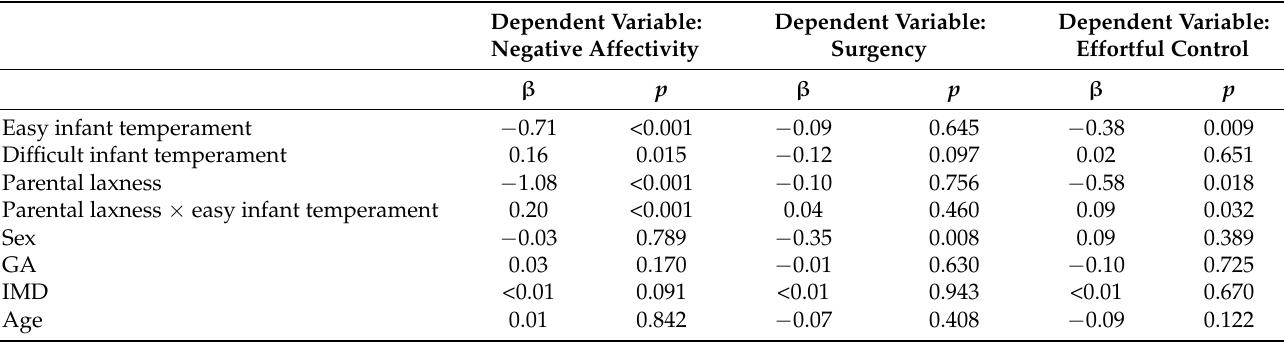
Table 5. Results of univariate follow-up analyses separately regressing Negative Affectivity, Surgency or Effortful Control on infant temperament, parental laxness and its interaction with easy infant temperament, controlling for age, sex, gestational age (GA) and index of multiple deprivation (IMD). A Bonferroni-corrected significance threshold of p = 0.003 was